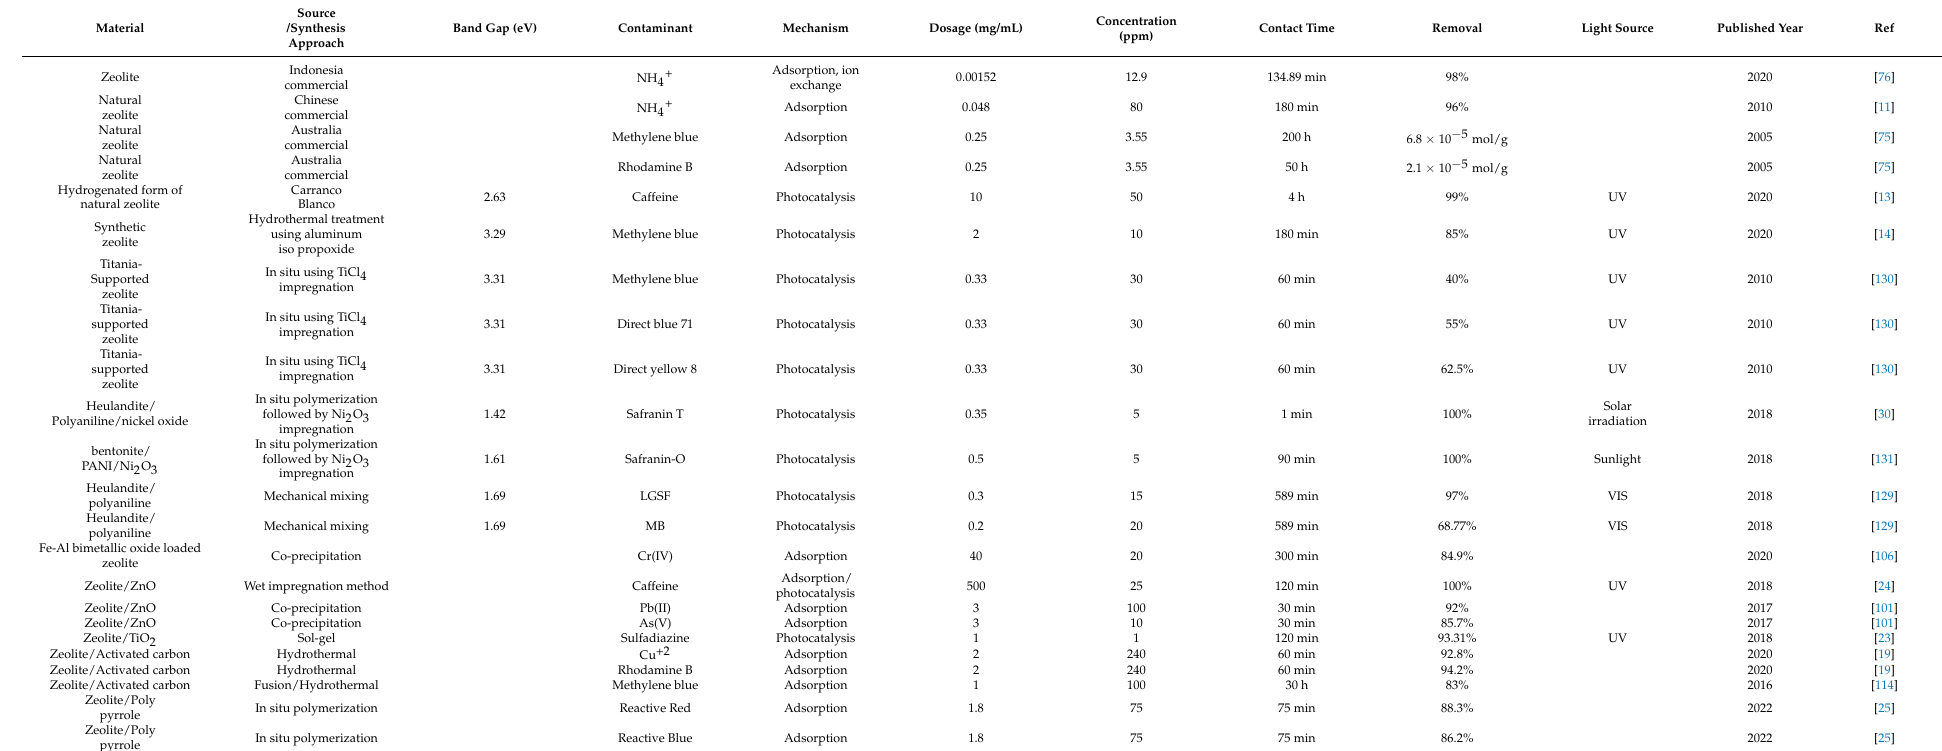
Table 8. Comparison of effluent removal efficiencies of zeolites and zeolite-based